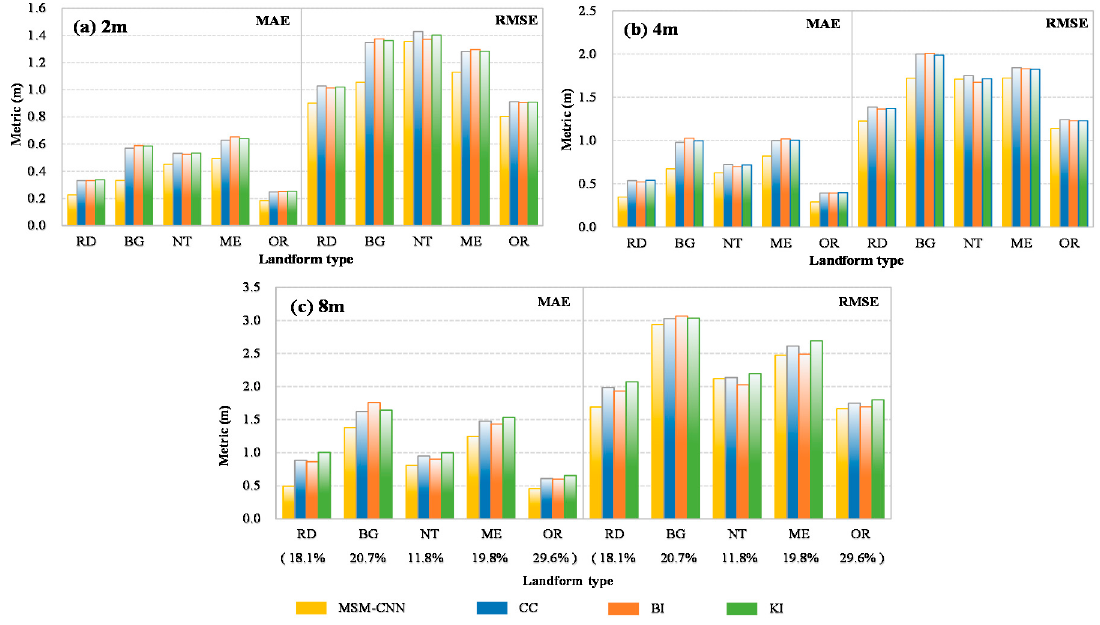
Figure 9. The accuracy metrics calculated for di ff erent land covers: ( a , b , c ) MAEs and RMSEs for di ff erent DEMs reconstructed from the 2, 4, and 8 m DEMs. The bracketed numbers below the x -axis in ( c ) indicate the frequency of each land cover.